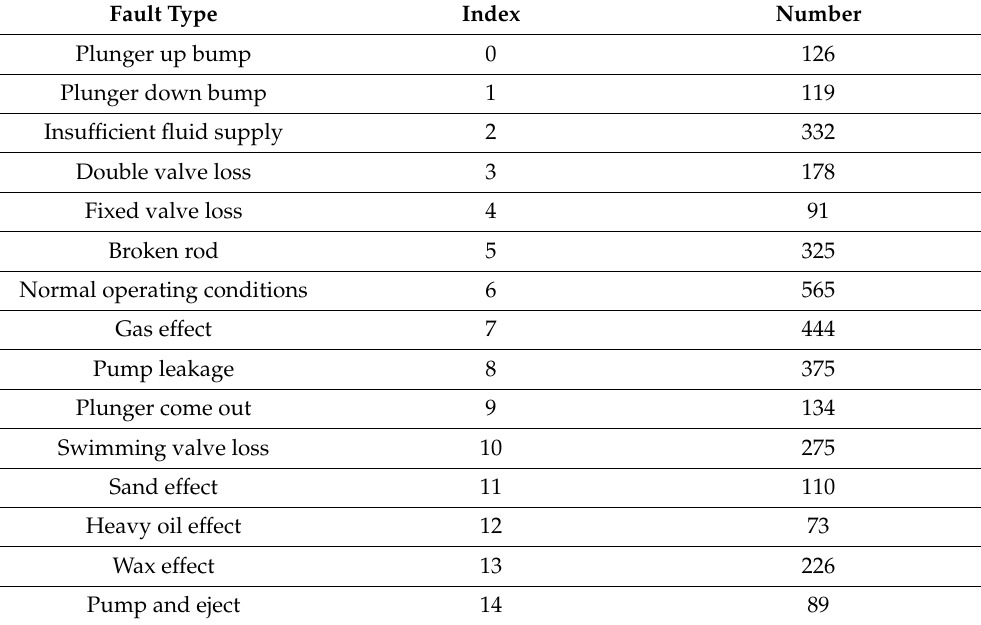
Table 1. Label index assignment